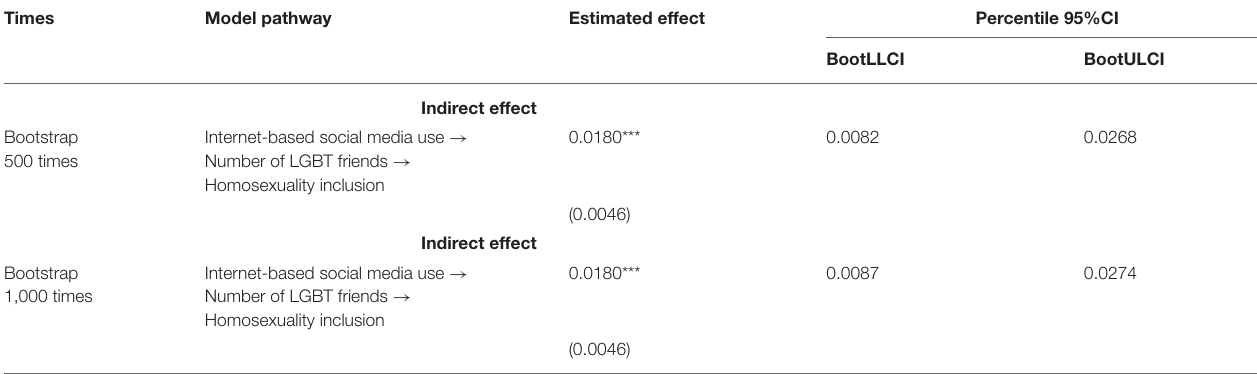
TABLE 5 | Mechanism analysis of Bootstrap